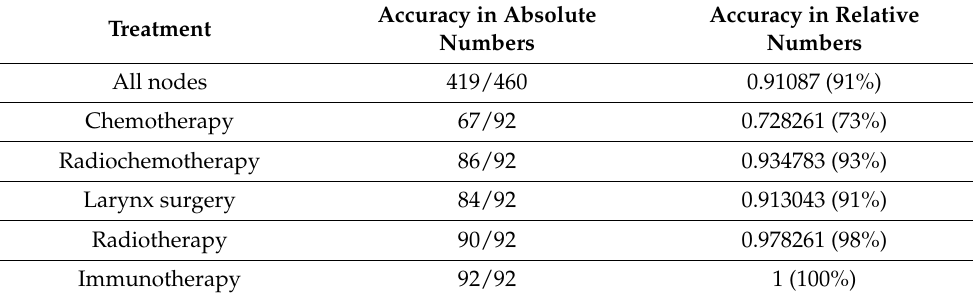
Table 3. Accuracy of the model calculation regarding the different treatment modalities.